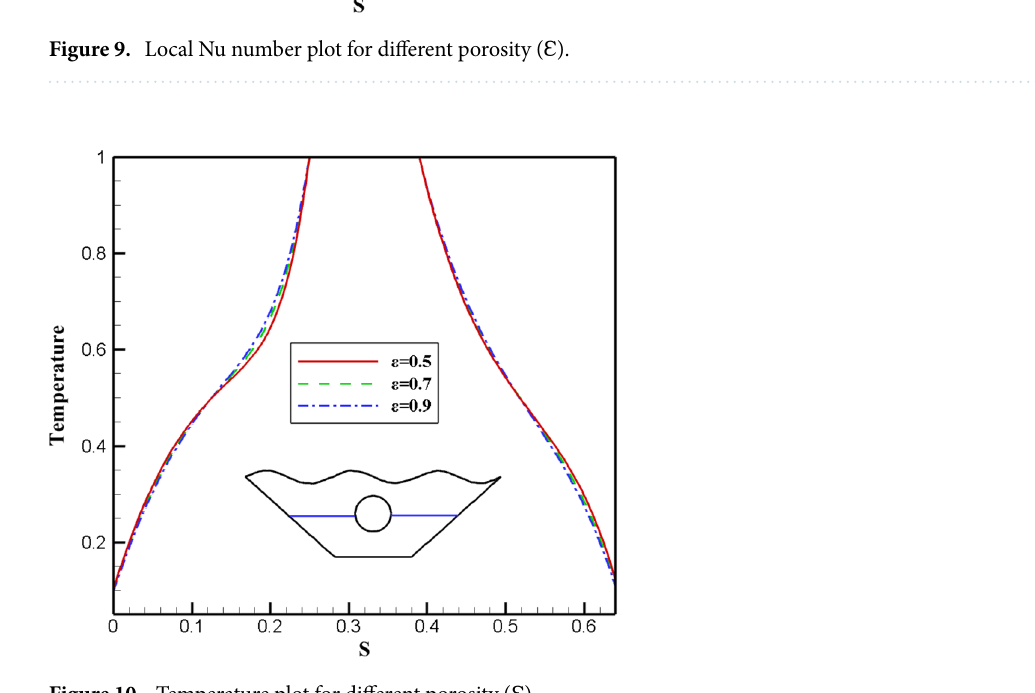
Figure 10. Temperature plot for different porosity ( ℇ